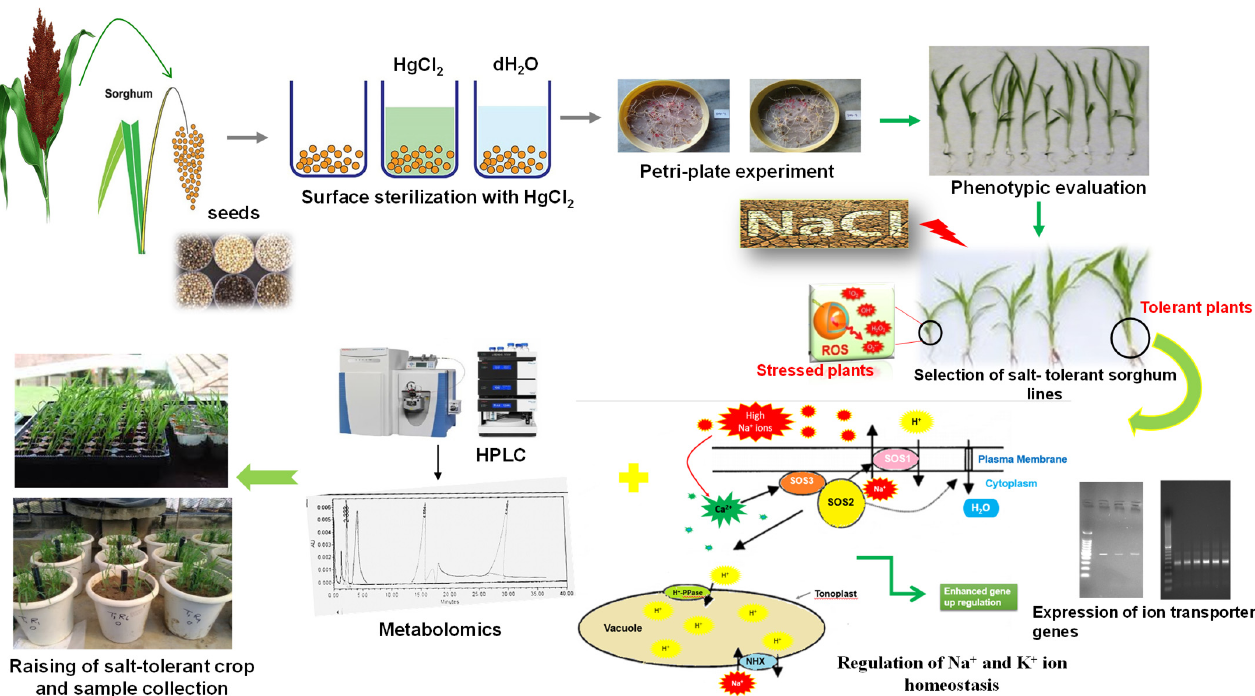
Figure 1. Outline of the experiment / Two S. bicolor genotypes (SSG 59-3 and PC-5) with varied salt tolerance were phenotypically evaluated based on germination studies and then planted in screen house under different salt concentrations. Leaves and roots from five plants were pooled and considered a biological replicate, and two such replicates were used in the analysis. HPLC was performed to evaluate the accumulation of polyamines under different salt concentrations. Total RNA was isolated from sorghum leaves and the expression pattern of ion transporters was studied.